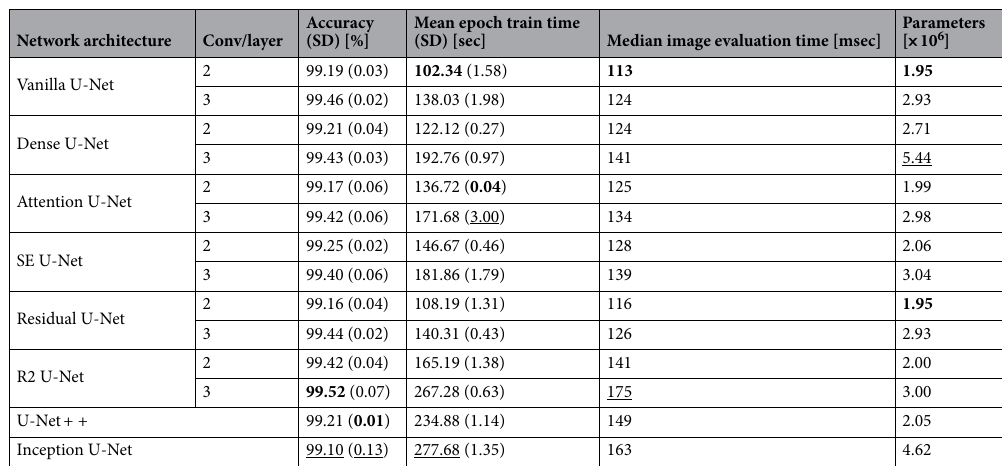
Table 5. Comparison of results for the widefield dataset. (SD: standard deviation, s: seconds, SE: squeeze + excite, R2: recurrent-residual). The best and poorest results for each are annotated in bold and underline text